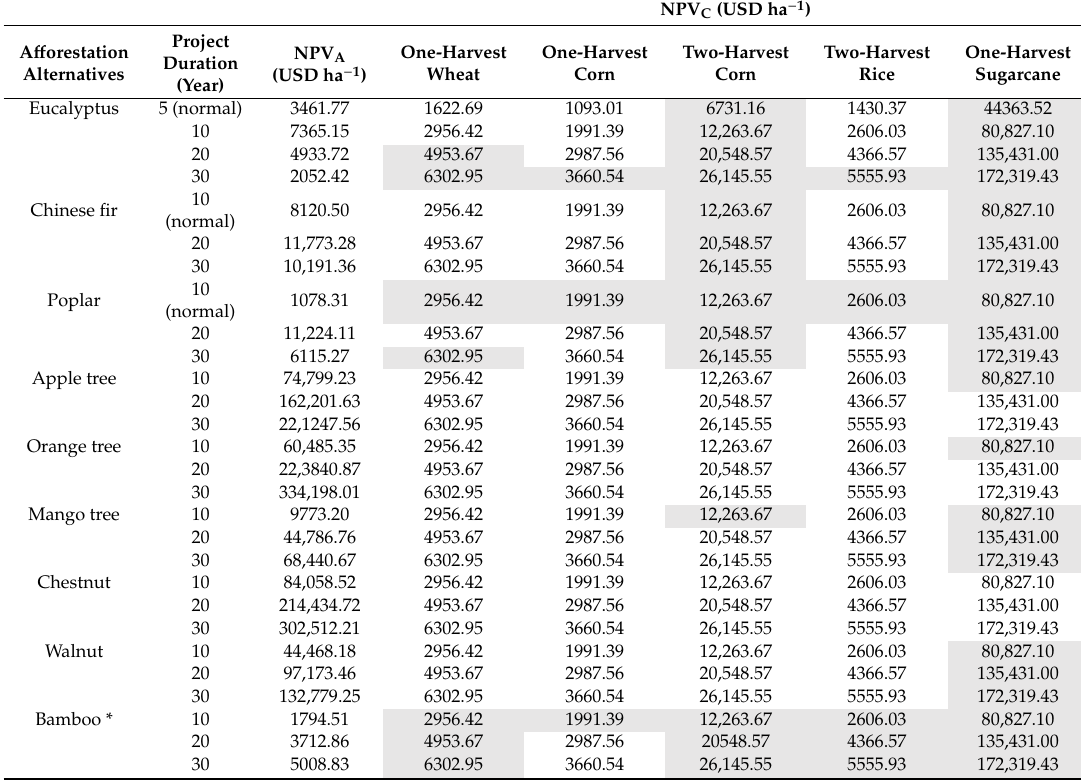
Table 5. Economic assessment of a ff orestation with various tree species and di ff erent rotation